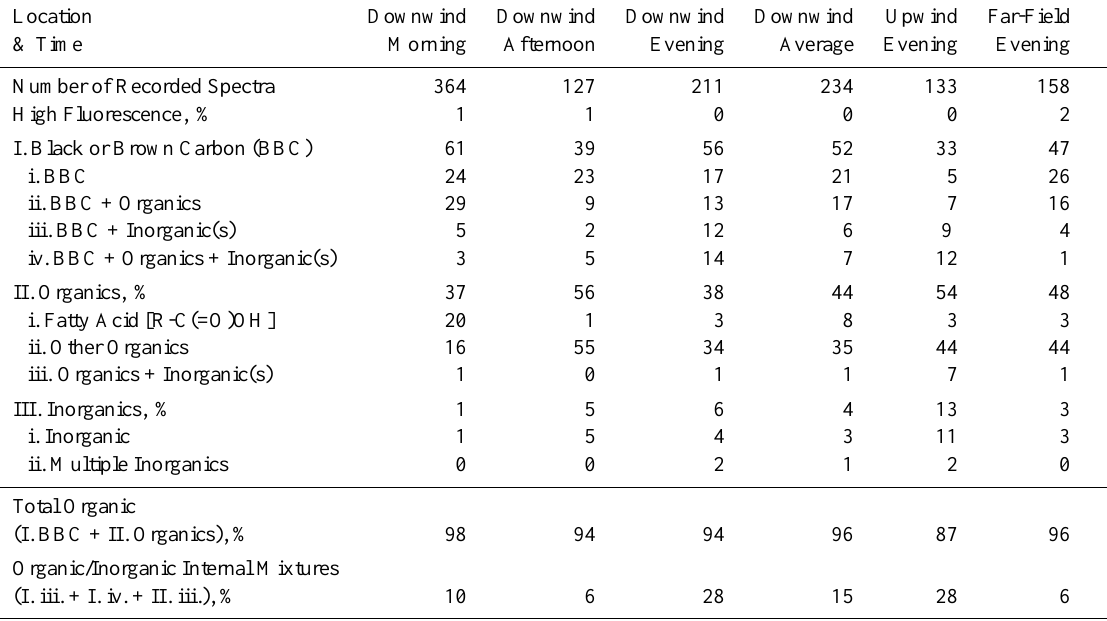
Table 2. Chemical classification of particles collected at the indicated sampling locations and times.